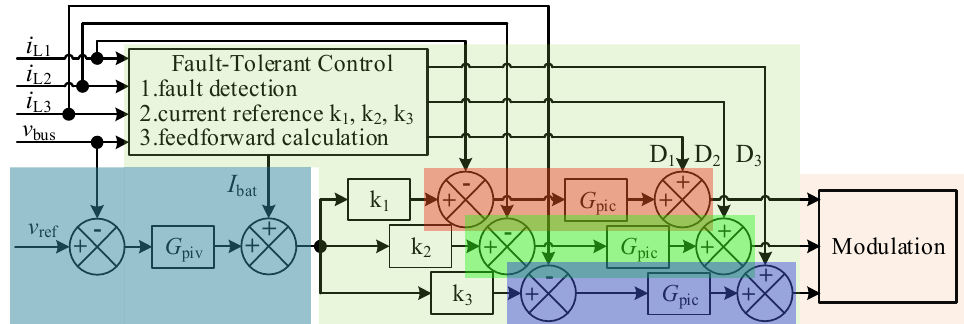
Figure 7. Control strategy of 3-phase coupled buck–boost converter in fault-tolerant op- eration.